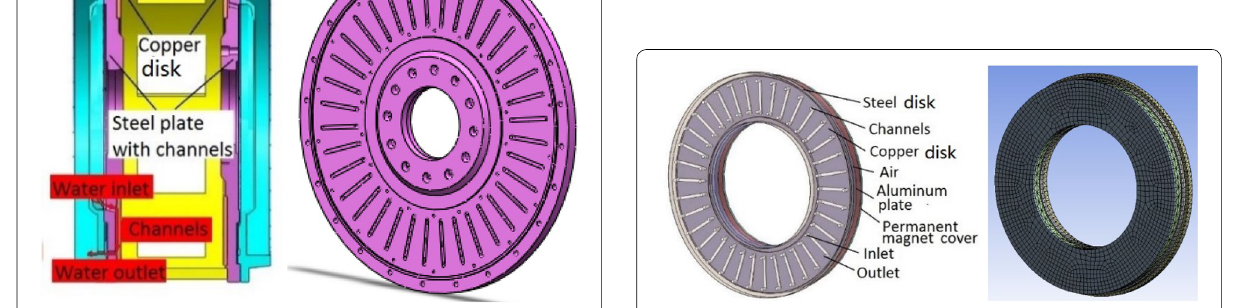
Figure 3 Cooling process and cooling channel Figure 4 Physical model and mesh